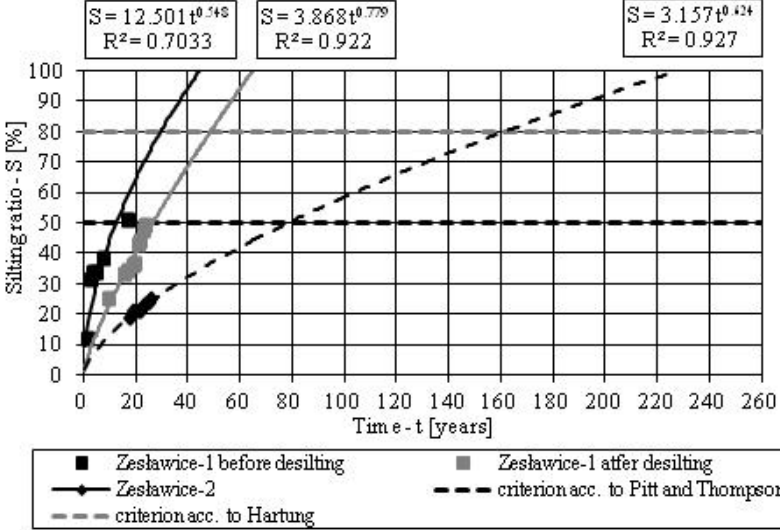
Figure 3. Correlation relationship between the silting rate of reservoirs at Zes ł awice and their time of